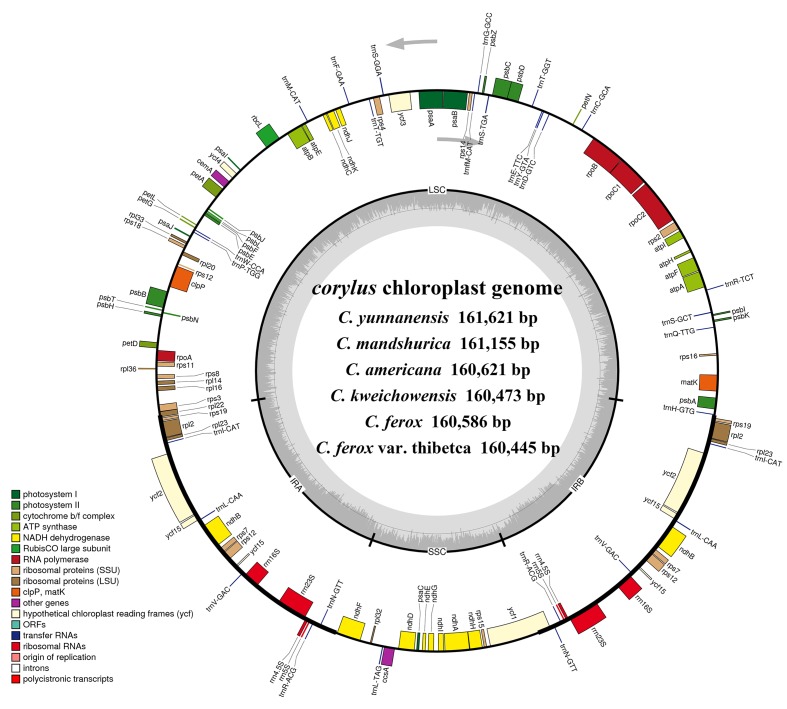
Gene maps of the six Corylus chloroplast genomes. Genes shown outside the outer circle are transcribed clockwise and those inside are transcribed counterclockwise. Genes belonging to different functional groups are color-coded. Dashed area in the inner circle indicates the GC content of the chloroplast genome.